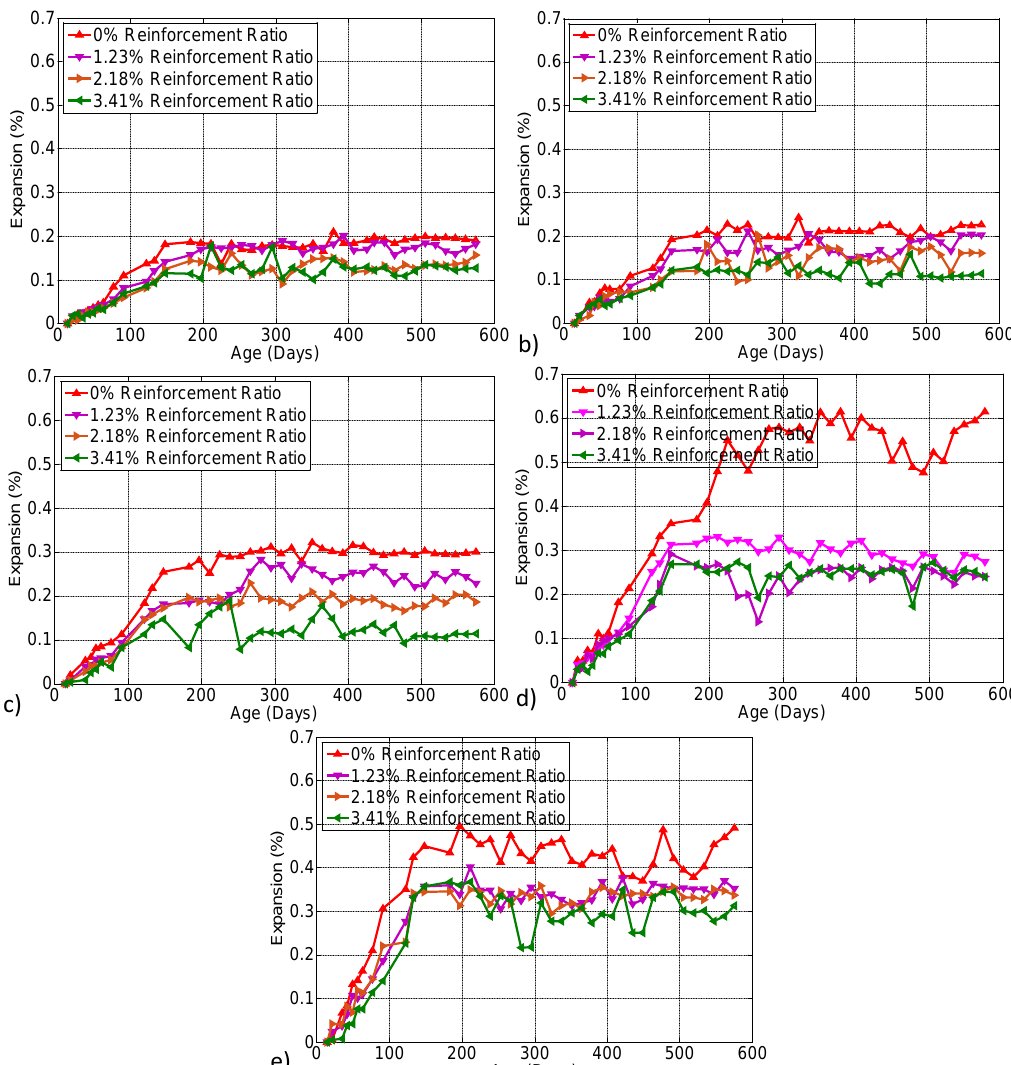
Figure 14. Expansion of prisms built from ( a ) NaOH-00 mixture and kept in the laboratory, ( b ) NaOH-00 mixture and conditioned outside, ( c ) NaOH-00 mixture and conditioned in the environmental chamber, ( d ) NaOH-12 mixture and conditioned outside and ( e ) NaOH-12 mixture and conditioned in the environmental chamber.